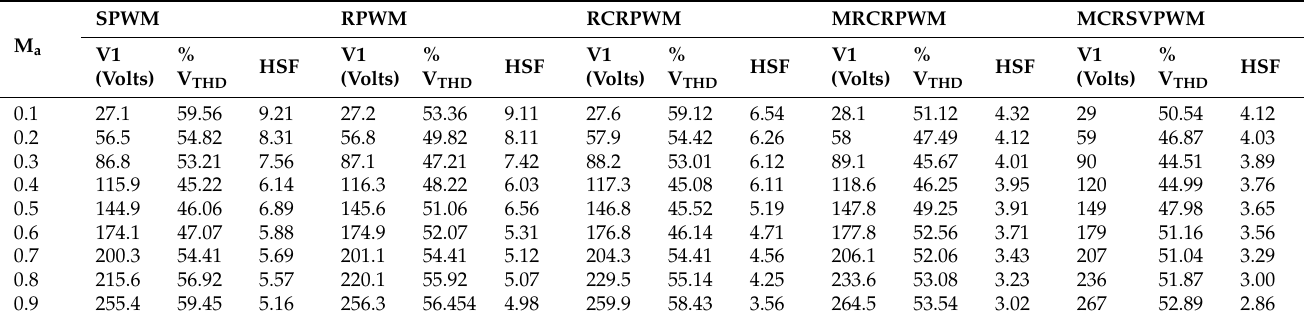
Table 5. The combined comparisons of line voltage and line voltage THD and HSF study results.